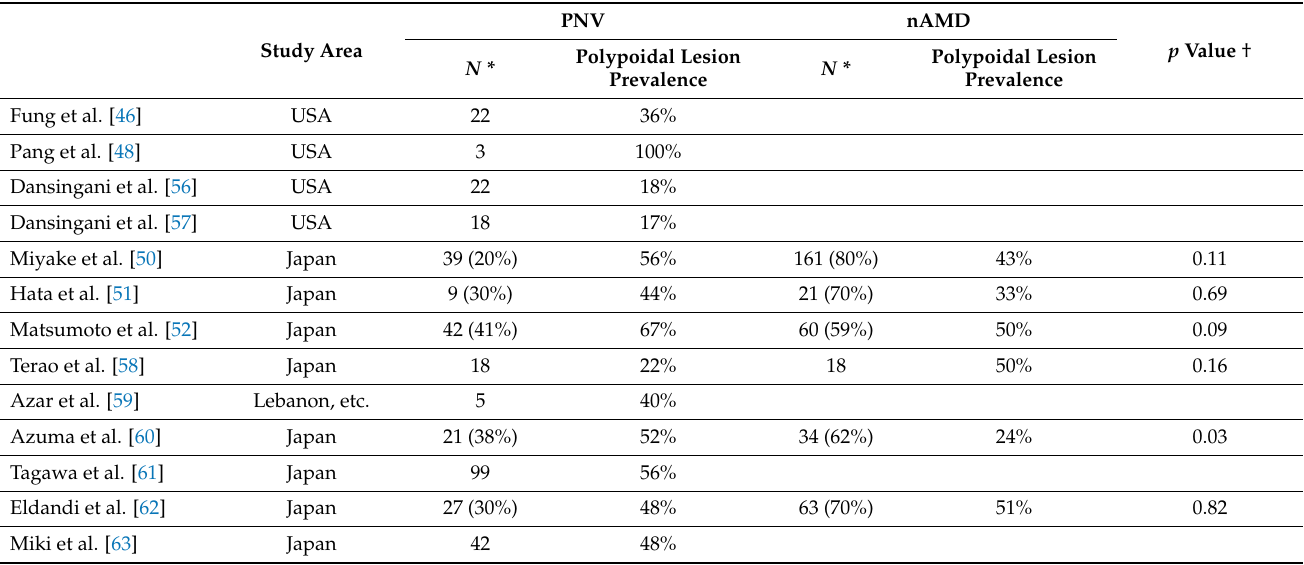
Table 7. Prevalence of polypoidal lesions in PNV and